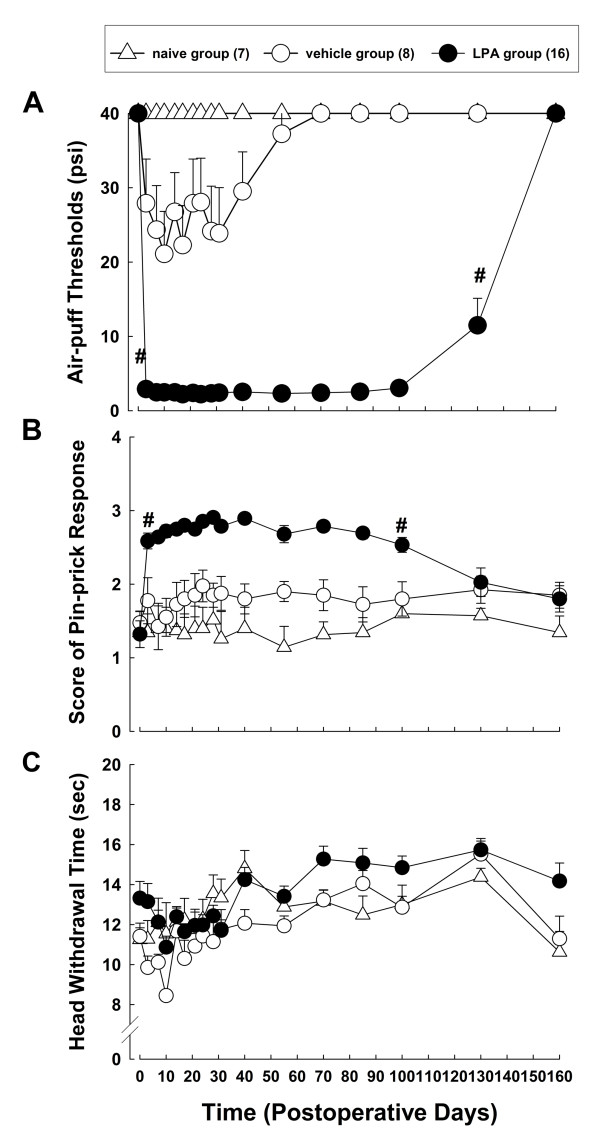
Prolonged nociceptive behavior following the microinjection of LPA into the trigeminal nerve root of the rat. (A) Time course analysis of changes in the air-puff thresholds. LPA-treated animals showed significant decreased air-puff thresholds on postoperative day 3. LPA-induced mechanical allodynia was maintained until postoperative day 130. (B) Time course analysis of changes in the pin-prick responses. LPA injection produced significant mechanical hyper-responsiveness to pin-prick stimulation compared with the vehicle-treated group. (C) Time course analysis of changes in the thermal nociception. # P < 0.05, vehicle- vs. LPA-treated group. All points between two identical symbols have the same level of significance.